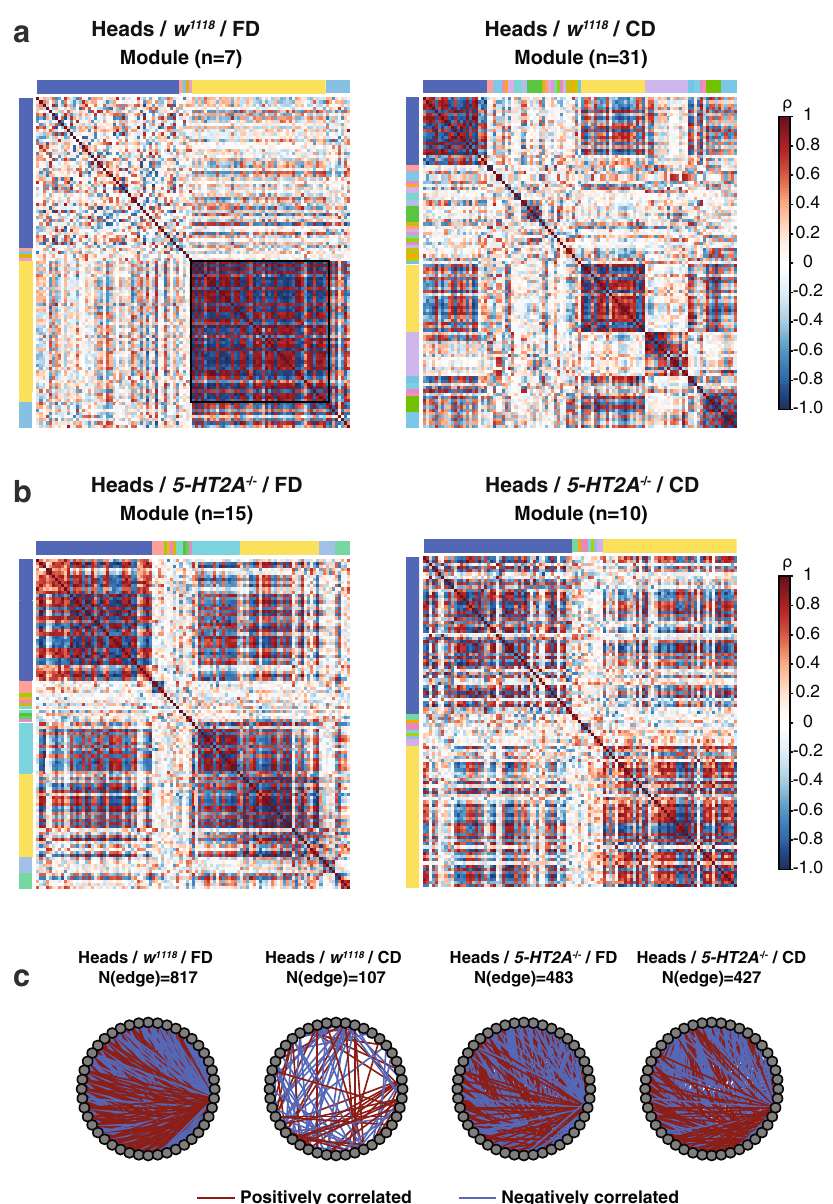
Fig. 4 Dietary choice induces the fragmentation of correlation networks partially through 5-HT2A. a , b Correlation plots showing the dietary in fl uences on the community structures in both control males ( a ) and 5-HT2A mutants ( b ). Color bars on the side and the top of the correlation plots indicate individual modules, with yellow and blue blocks representing the dominant ones (those who have the most metabolites out of all the modules) in each group. a In the head metabolomes of control fl ies that fed on a choice diet, we observed an increase in the number of modules and a decrease in the size of the dominant modules, compared to that of their siblings from a fi xed diet. b Dietary differences are eliminated in 5-HT2A mutants. c Metabolite – metabolite interactions in the yellow major group are largely lost in the CD networks that are derived from the heads of control males, while part of them are restored in the 5-HT2A